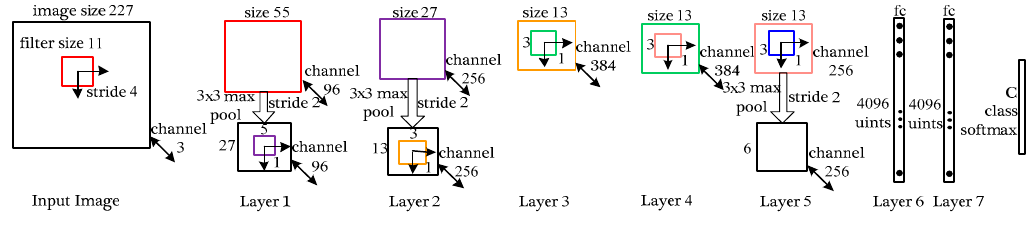
Figure 4. An illustration of used CNN architecture. The network’s input is 154,587 dimensional and the number of neurons in the network’s remaining layers is given by 290,440-186,624-64,896-64,896-43,264-4096-4096-4. The numbers of convolutional parameters and fully connected parameters in the network is given by 34,944-614,656-885,120-1,327,488-884,992-37,752,832-16,777,216-16,384.